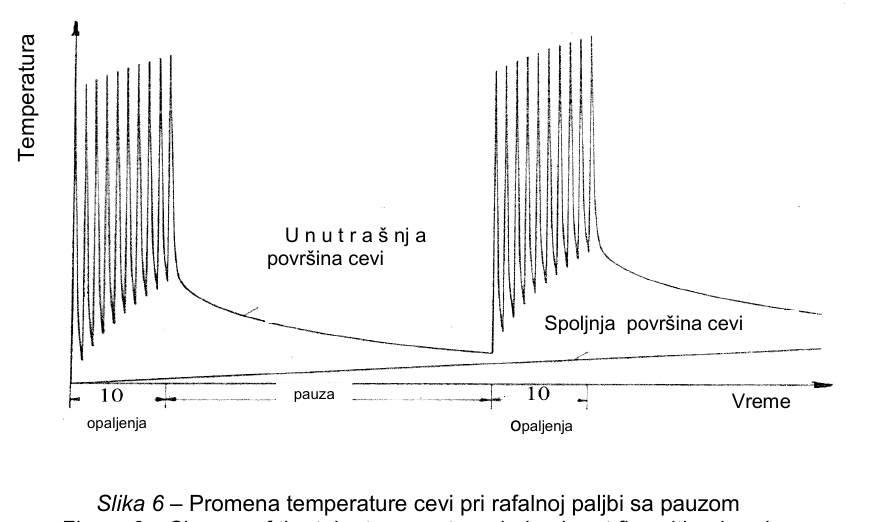
Figure 6 – Change of the tube temperature during burst fire with a